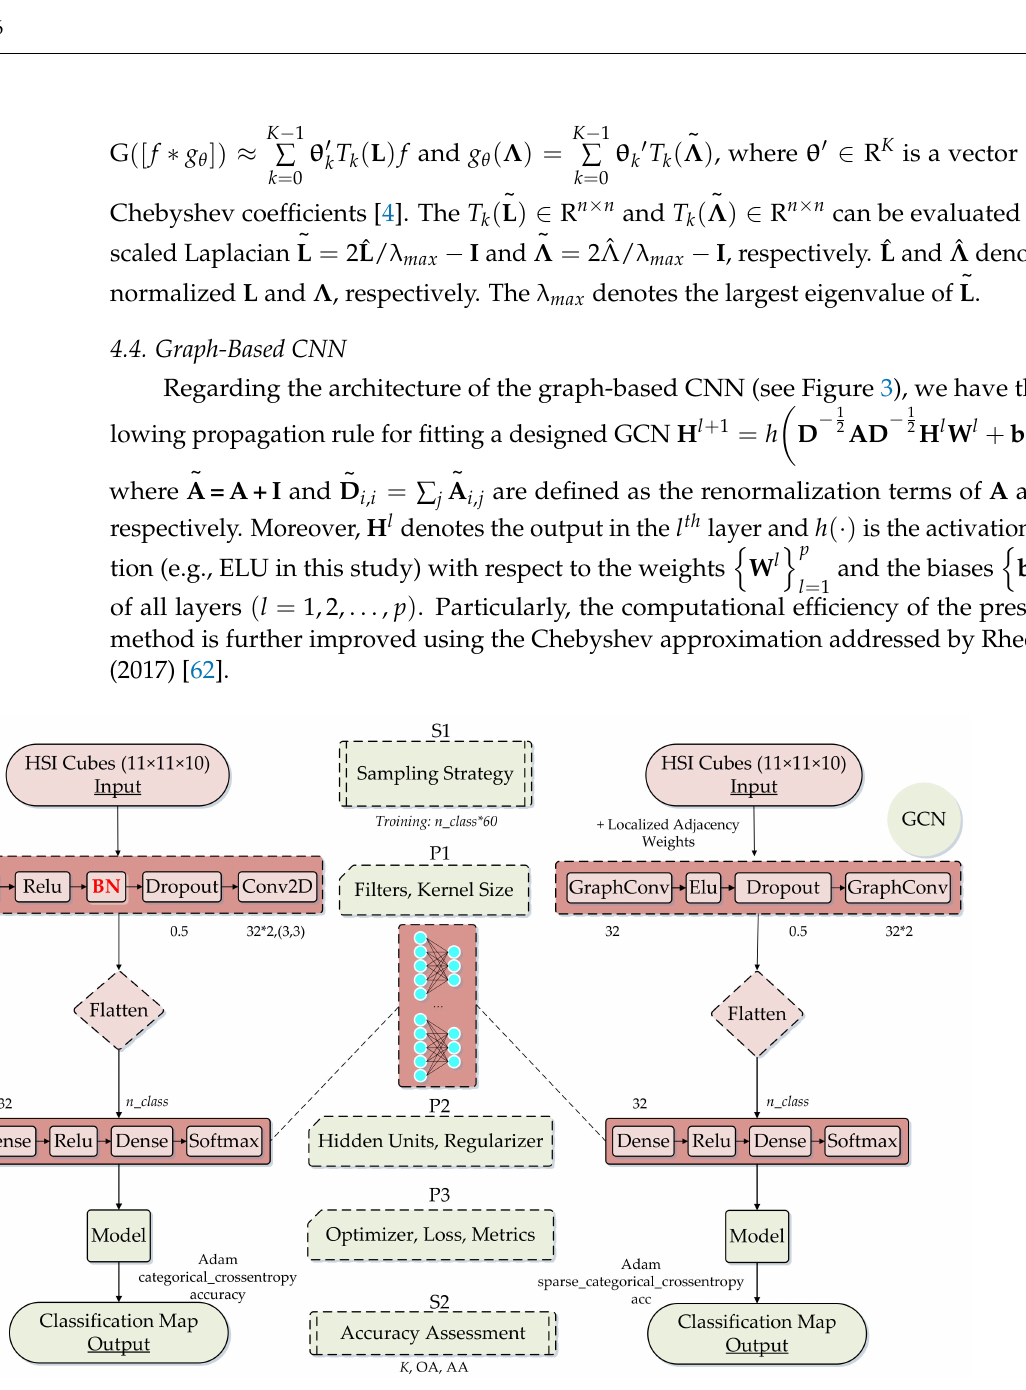
Figure 3. The architecture of the proposed convolutional neural network (CNN) and graph convolutional network (GCN). Here, S i { i = 1, 2} denotes the key sub-flows, and P j { j = 1, 2, 3} represents several sets of parameter settings. Note that the CNN and GCN are completely independent